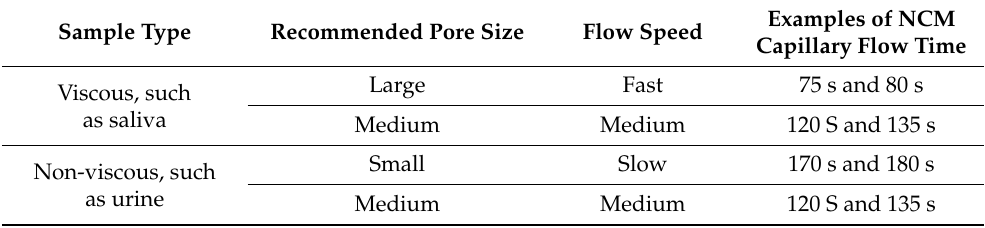
Table 1. Relationship between the sample type, the NCM pore size, and the NCM flow